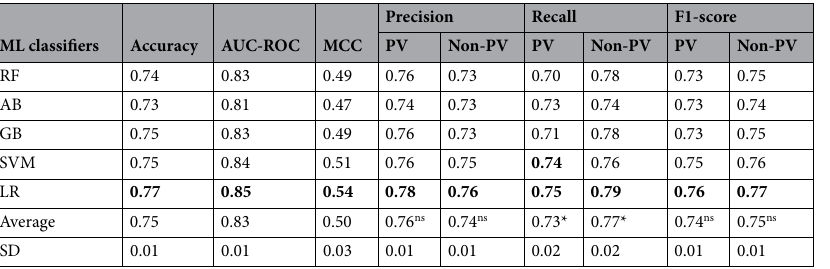
Table 5. The average performance of different machine learning algorithms after ten iterations. Bold letter indicates best score in each measure. ML machine learning, AUC-ROC area under the receiver operating characteristic curve, MCC Matthews correlation coefficient, PV peripheral vestibular disease, non-PV non- peripheral vestibular disease, RF Random Forest, AB AdaBoost, GB Gradient Boosting, SVM Support Vector Machine, LR Logistic Regression, SD standard deviation. *P < 0.05 between PV and non-PV, ns no significant difference between PV and non-PV.